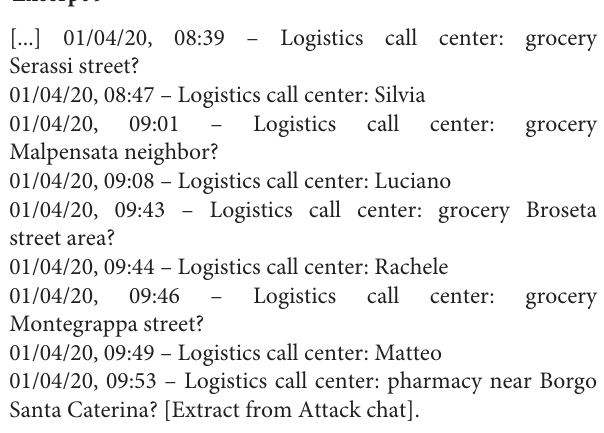
settings, the “Attack” group chat shifted from a many-to-many group chat model, to one where replies became specific rather than general responses to